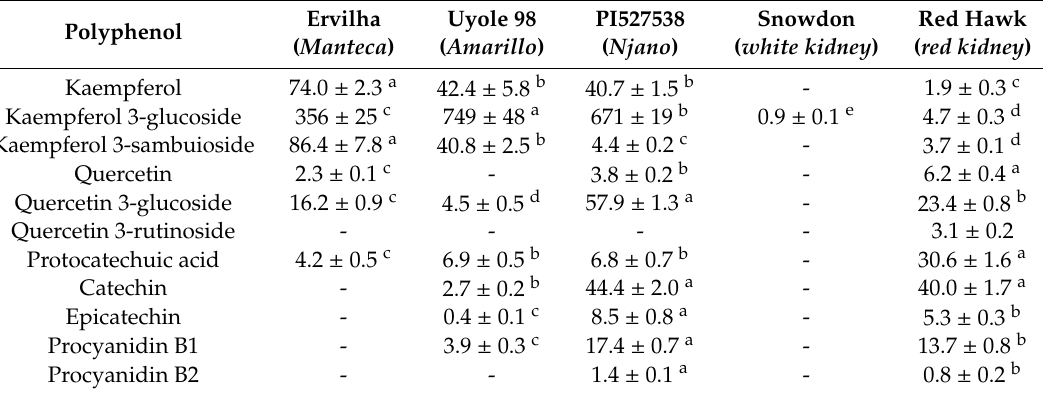
Table 4. Polyphenol Concentrations (nmol / g) of Cooked Beans.